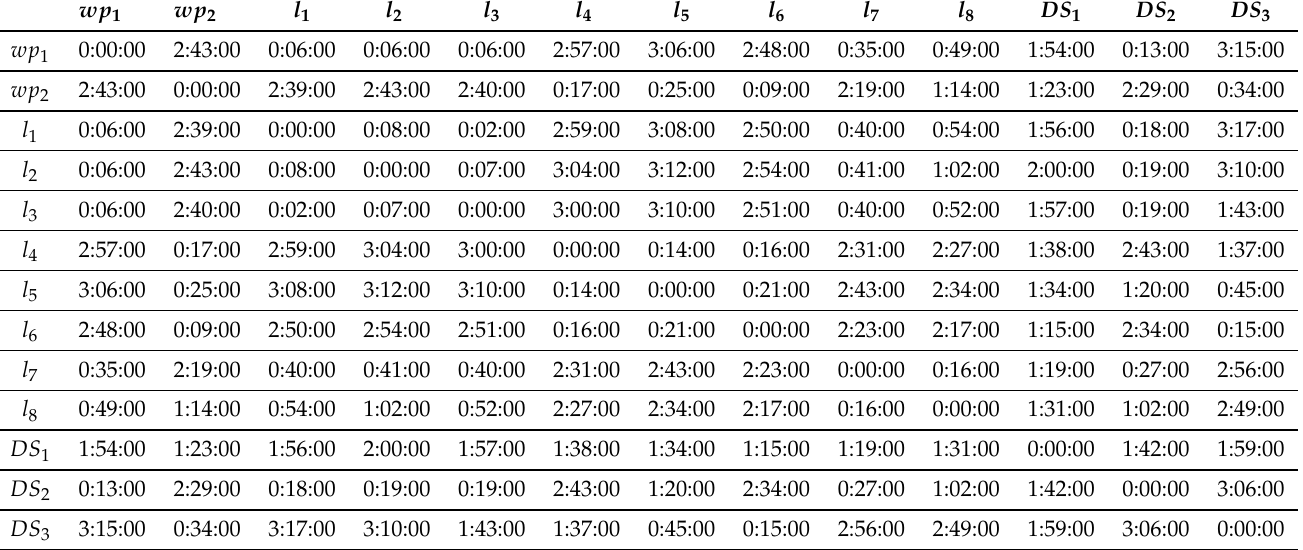
Table A2. Time distance matrix based on walking displacements. A cell c ij indicates the time required to move from